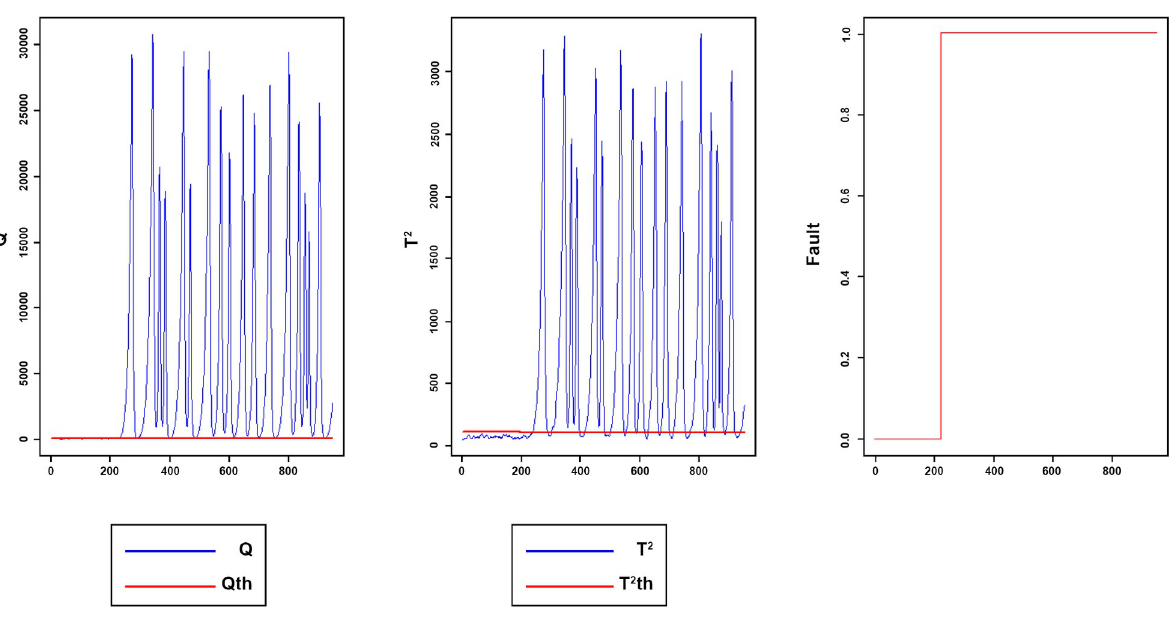
Fig 15. Monitoring performance of MWDPCA for fault 17.